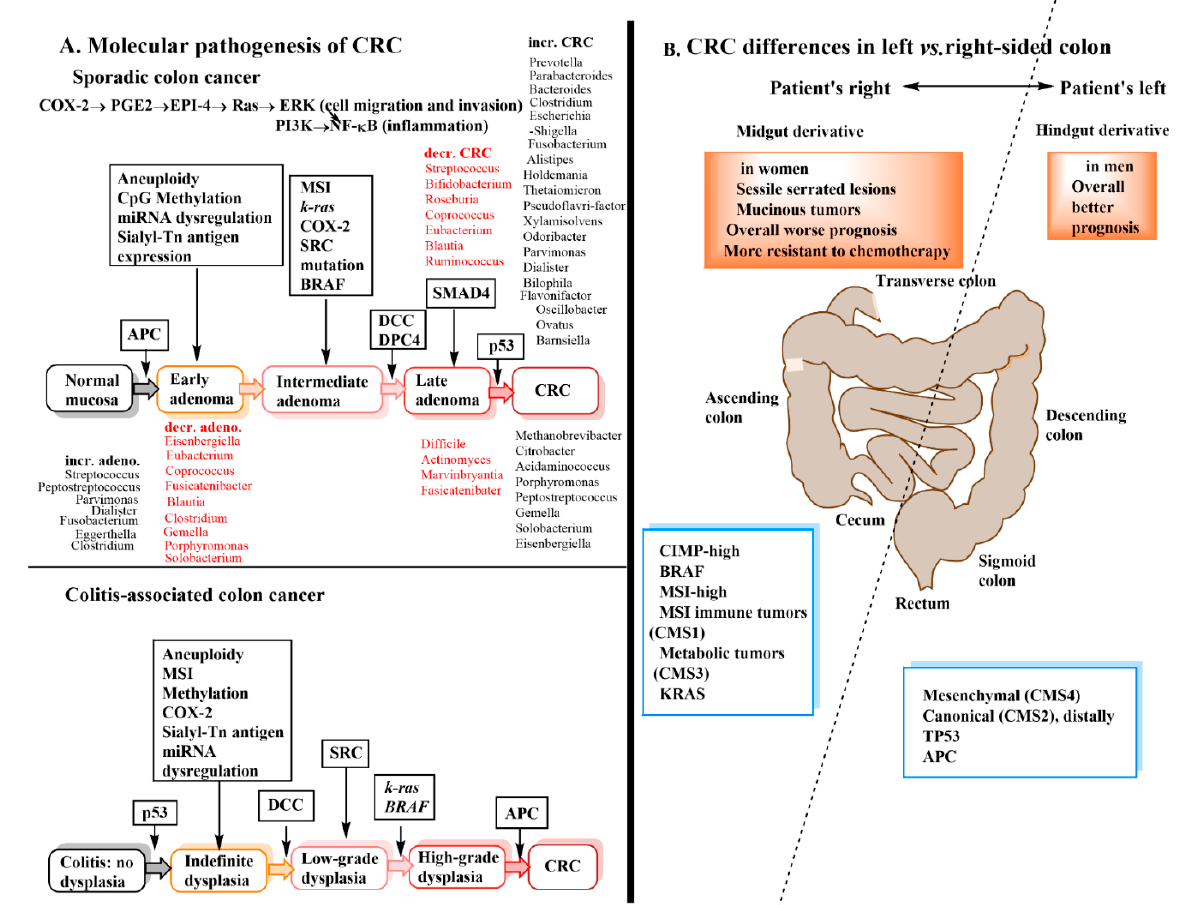
Figure 3. ( A ) The molecular pathogenesis of CRC. There are two broad classifications of CRC based on differences in the sequence of mutations leading to the cancer as well as their histological presentation. Sporadic CRC (SCRC) (top) develops from dysplasia of 1 or 2 discrete foci of the colon. The primary event in the formation of early adenomas is the loss of APC protein function. The APC protein is a negative regulator of beta-catenin that helps to control how often a cell divides and is the product of the tumor suppressor gene APC. Early adenoma is also accompanied by expression of the mucin-associated carbohydrate antigen, sialyl-Tn [36], miRNA dysregulation and progression to an intermediate stage of adenoma that is characterized by activation of the oncogenic k-ras gene and COX-2. COX-2 induction leads to production of the pro-inflammatory prostaglandin PGE 2 which in turn binds to EP1-4 leading to several important pathways (shown in the figure) that promote CRC progression from early to intermediate adenoma stages [37]. The intermediate adenoma stage is also characterized by SRC overexpression and subsequent promotion of CRC cell proliferation and survival [38]. The loss of the tumor suppressor genes DCC and DPC4 often occur in the progression from intermediate to late adenoma [39]. The advancement to CRC from late adenoma is characterized by loss of p53 as the final mutation event. Colitis-associated CRC (CCRC) first presents as dysplastic lesions that are polyploidy, flat, localized or multifocal and which are the product of chronic inflammation. Rather than distinct polyps (adenomas) there is instead a large spreading region that often indicates removal of the entire colon and rectum [40]. There are some major differences in the timing and sequence of mutations from those seen for SCRC. Rather than adenoma stages there are instead varying degrees of epithelial dysplasia in the staging of the disease. Abbreviations: sporadic CRC (SCRC), colitis-associated CRC (CCRC), adenomatous polyposis coli (APC), microsatellite instability (MSI), Kirsten rat sarcoma viral oncogene homolog (k-ras), cyclooxygenase-2 (COX-2), prostaglandin E 2 (PGE2), dependence receptor in colorectal cancer (DCC), deleted in pancreatic cancer-4 (DPC4), proto-oncogene tyrosine protein-kinase Src 5 (SRC). ( B ) CRC differences in left vs. right-sided colon. The molecular features of left-sided (distal) colon cancers are different from right-sided (proximal) colon cancers. Based on the different gene expressions in CRC, four consensus molecular subtypes (CMS, 1-4) have been identified; MSI immune (CMS1), canonical (CMS2), metabolic (CMS3), and mesenchymal (CMS4). The left-sided cancers have better prognosis because they are less resistant to chemotherapy (CMS2, 4). Sidedness is particularly relevant during metastasis and is predictive of drug response